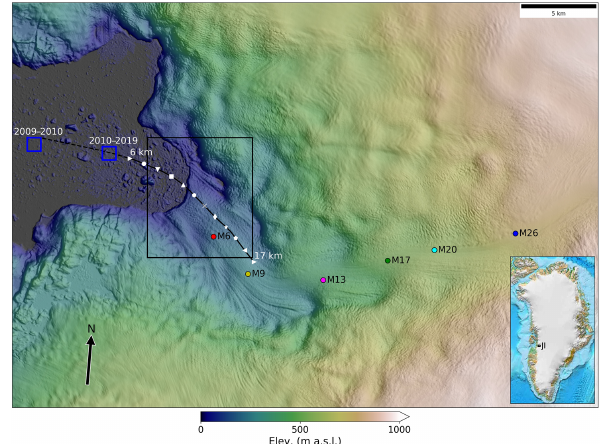
Figure 1. Surface elevation (colour) over a shaded relief map de- rived from the Greenland Ice Mapping Project (GIMP) DEM for the region near the terminus of Jakobshavn Isbræ (see inset for lo- cation). The black box shows the location of the images shown in Figs. 4 and 8 and the blue box indicates the areas used to sam- ple mélange as described in the text. The solid black line shows the location of the profile shown in Figs. 3 and 7, with the dashed section used to show the full extent. White markers with assorted symbols denote 1km intervals along the profile between 6 and 17km. Coloured markers (M6–M26) show where speed is sam- pled in Fig. 2 at points consistent with earlier work (Joughin et al., 2008b, 2012b,